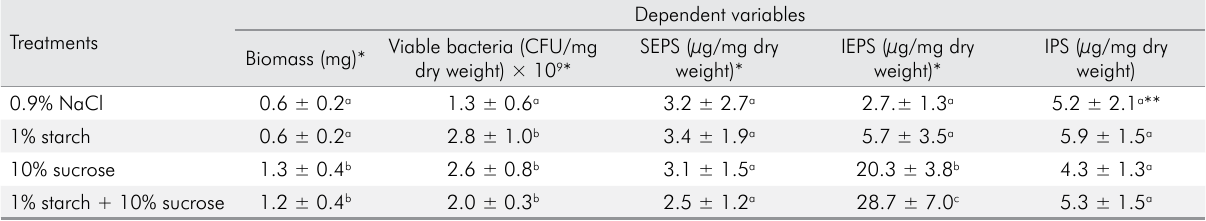
Table 2. Composition of biofilms formed on dentine subjected to the indicated treatments (mean ± SD, n = 9) Treatments